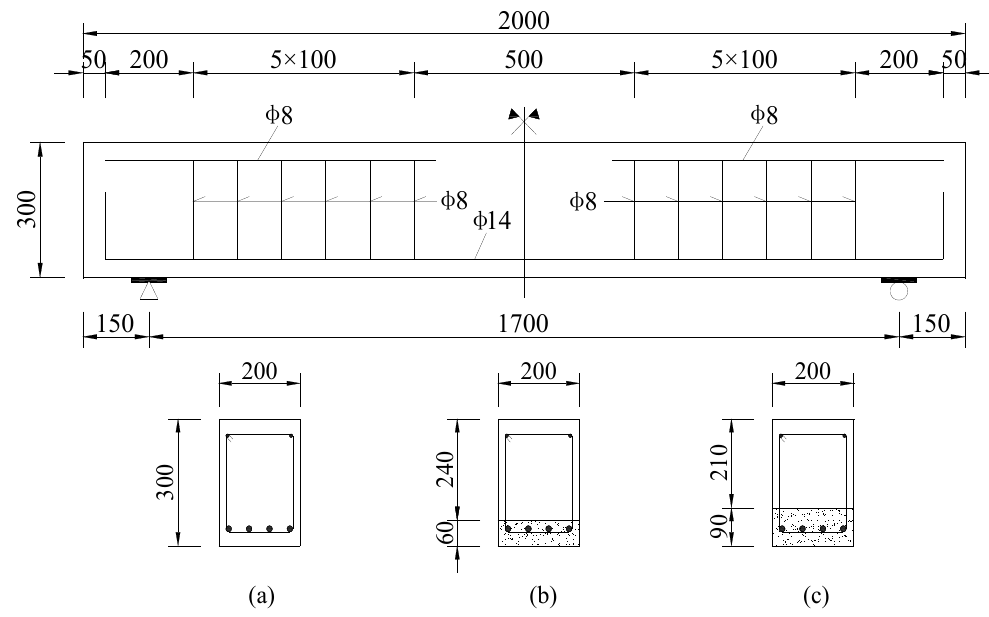
Figure 2. Longitudinal and cross section of the test beams: ( a ) RC beam, ( b ) BE1, ( c ) BE2 (unit: mm).